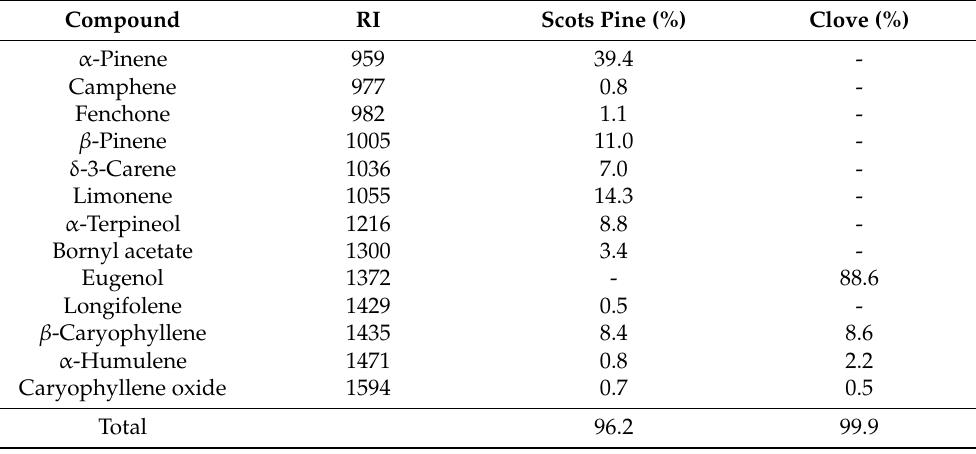
Table 1. The chemical composition of the investigated essential oils in percentage from 3 parallel measurements (RI: retention index).